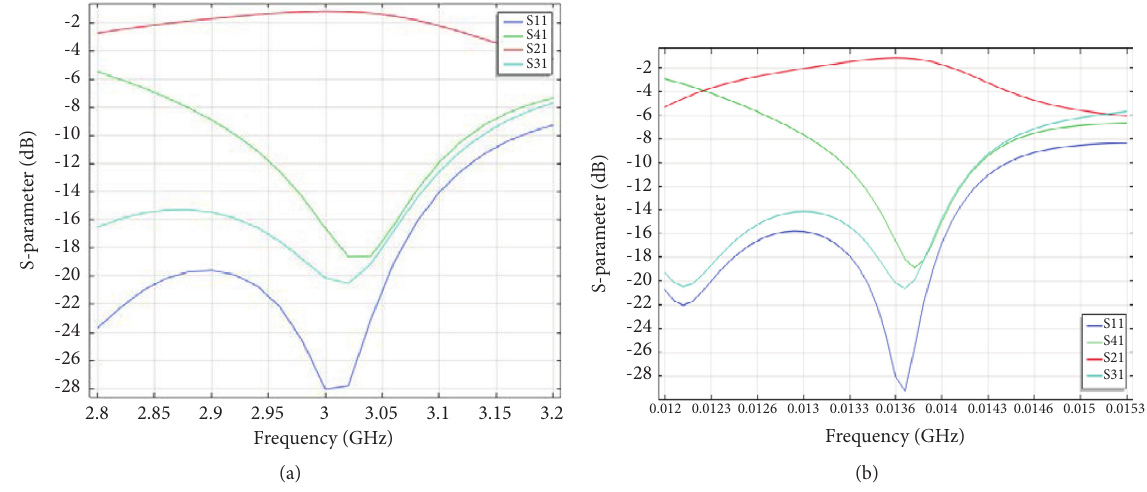
Figure 4: Power diagram in terms of (a) frequency (GHz) and (b) ferrite size